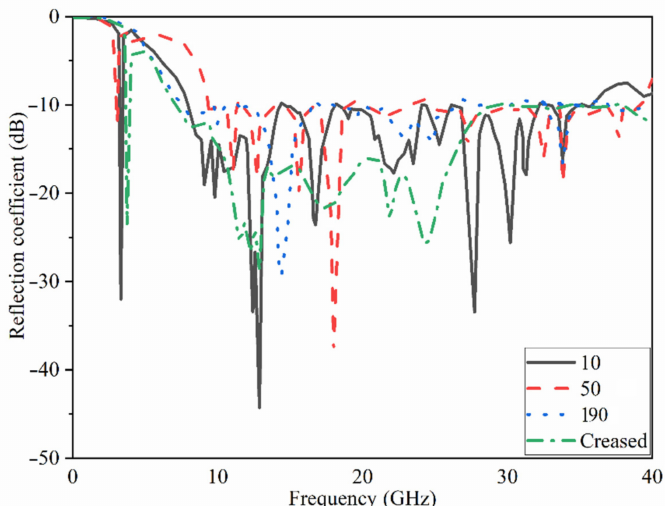
Figure 25. Reflection coefficient results of flexibility investigation for the proposed 8 ports UWB- MIMO (in degrees) when antenna 1